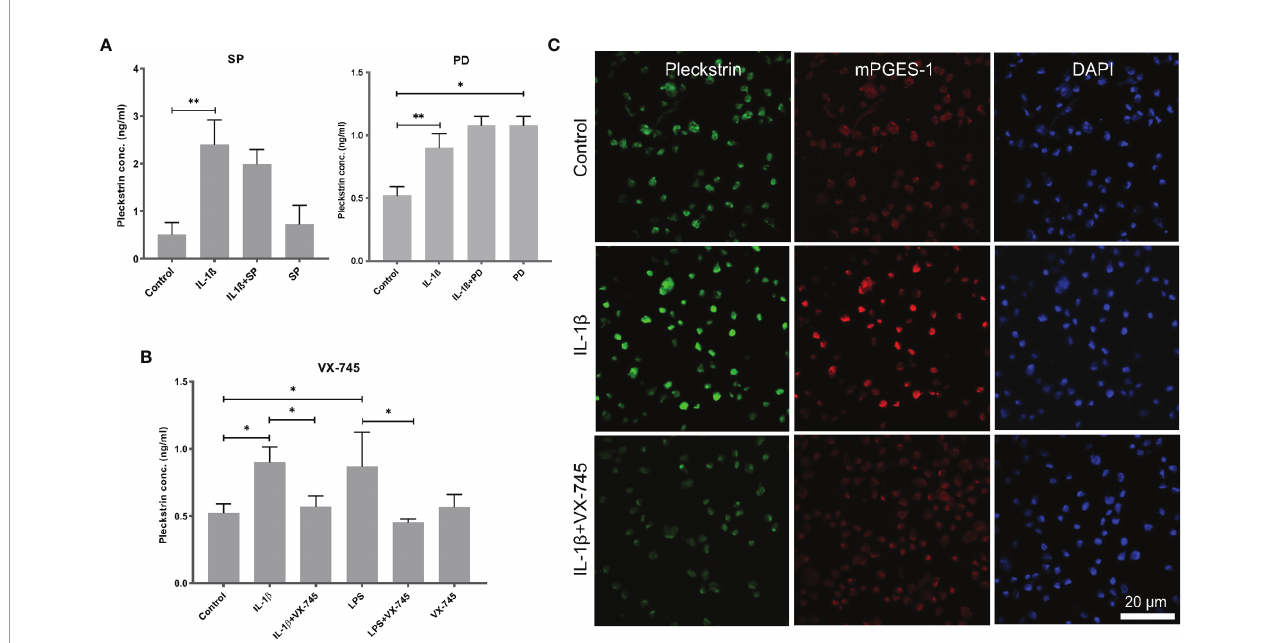
FIGURE 5 | Extracellular pleckstrin detection in HGFs using ELISA. (A) Bar plot demonstrating extracellular pleckstrin levels in HGFs stimulated with IL-1 b and/or LPS treatment alone or in combination with signal transduction pathway inhibitors SP and PD. (B) Bar plot showing extracellular pleckstrin production after IL-1 b or LPS treatment alone or in combination with p38 a MAPK inhibitor VX-745 in gingival fi broblasts. (C) Immuno fl uorescence staining of pleckstrin and mPGES-1 expression after IL-1 b treatment for 24 h alone or in combination with p38 a MAPK inhibitor VX-745 in gingival fi broblast cells. The confocal images depict the localization of pleckstrin (green) and mPGES-1 (red) with DAPI (blue) staining which was used as a nuclear marker. Isotype or unstained controls for pleckstrin and mPGES-1 staining are used for revealing the speci fi city of the staining (data not shown here). Scale bars: 20 m m. Data are presented as the mean values ± SD from at least three independent experiments. Signi fi cance was calculated with one-way ANOVA with Tukey ’ s multiple comparisons test where p-values were set as *p ≤ 0.05 and **p ≤ 0.01. SP, SP600125 (inhibitor of c-Jun N-terminal kinase JNK); PD, PD 153035 hydrochloride (inhibitor of the epidermal growth factor receptor tyrosine kinase EGFR); VX-745, Ne fl amapimod (selective inhibitor p38 a MAPK